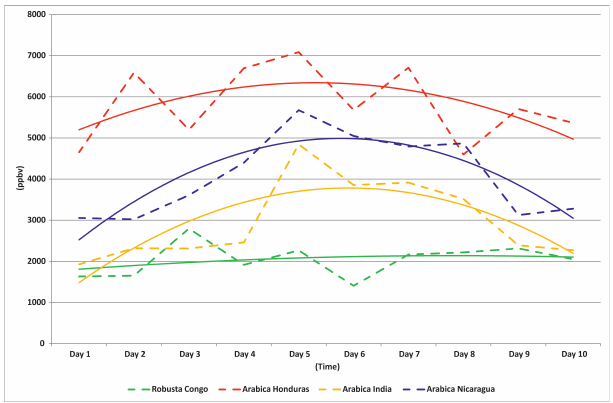
Fig. 1 - Total VOCs emission (ppbv) in the different Coffee stocks over the time (dotted line) and related trend curves (whole